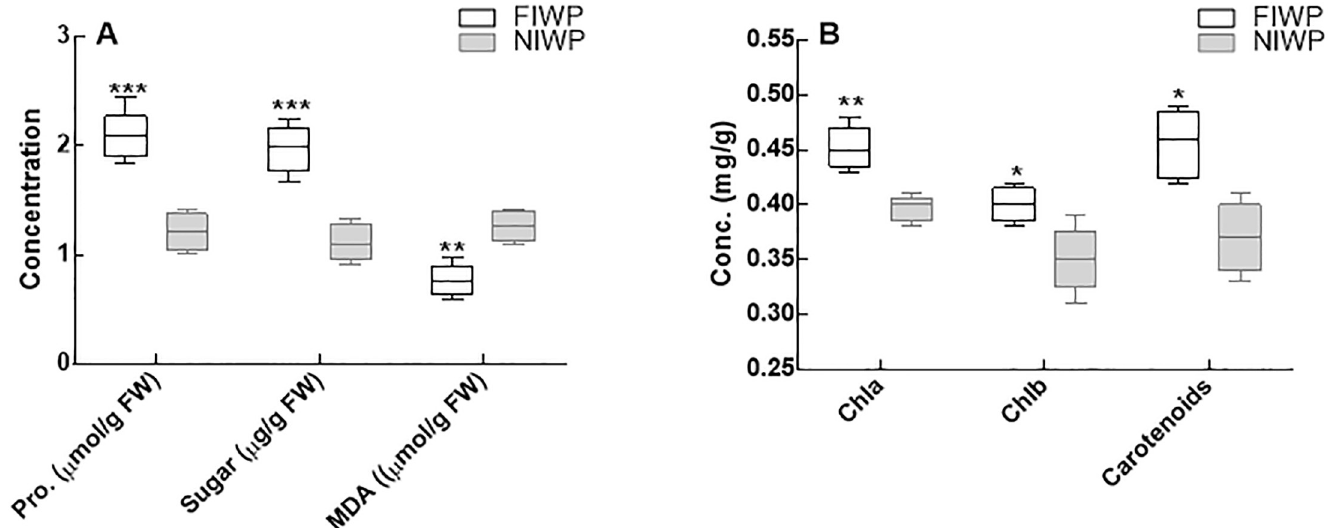
Fig 5. Biochemical contents of CGF-1 inoculated and non-inoculated wheat plant. Fig 5A = proline, sugar and malondialdehyde contents of CGF-1 inoculated and non-inoculated wheat plant grown under heavy metal stress; Fig 5B = Chla, Chlb and carotenoid contents of CGF-1 inoculated and non-inoculated wheat plant grown under heavy metal stress; FIWP = fungal inoculated wheat plant; NIWP = non-inoculated wheat plant; Pro = proline; MDA = malondialdehyde; Chla = chlorophyll a; Chlb = chlorophyll b. The experiment was carried out in triplicate, each replicate comprised of 10 pots and each pot contained 6 seedlings (total = 6 × 10 × 3 = 180 seedlings per treatment). Means of fungal inoculated wheat plants (FIWP) were compared with non-inoculated wheat plants (NIWP) by using ttest; ‘ ��� ’ represents significant difference at P = 0.0005; ‘ �� ’ represents significant difference at P = 0.005; ‘ � ’ represents significant difference at P = 0.05.